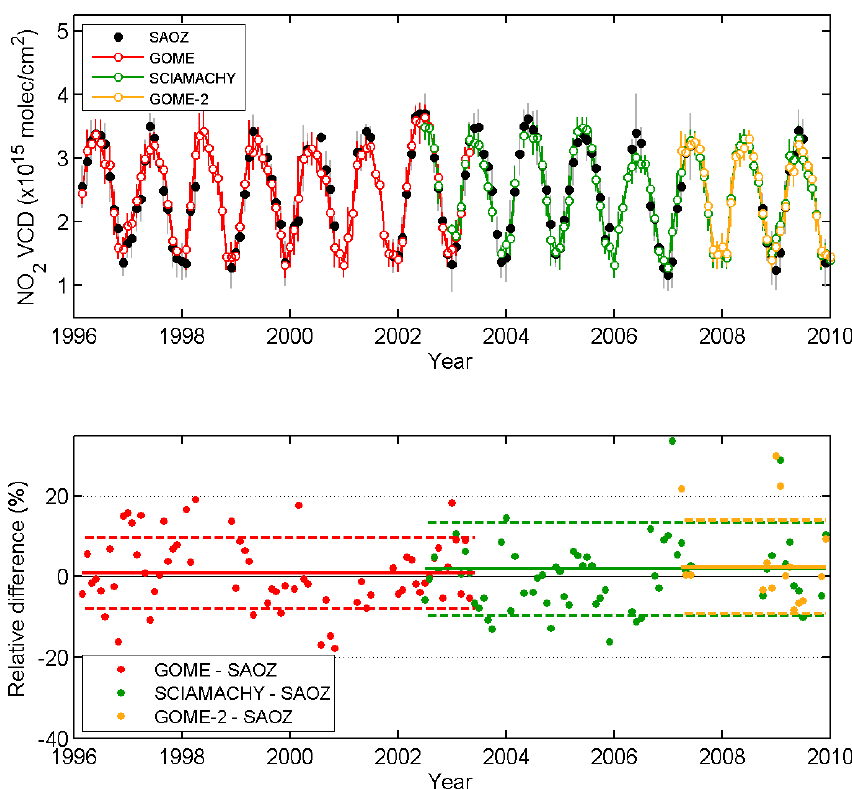
Fig. 3. Comparison between SAOZ and satellite nadir (GOME, SCIAMACHY, and GOME-2) monthly mean stratospheric NO 2 columns at Jungfraujoch (46.5 ◦ N, 8 ◦ E) for the 1996–2009 period. The error bars correspond to the 1-sigma standard deviation (natural variability). The relative differences appear on the lower plot with solid and dashed colored lines corresponding to the mean satellite – SAOZ differences and their one-sigma standard deviation, respectively, which are + 0.9 ± 8.8% (GOME), + 1.9 ± 11.5% (SCIAMACHY), and + 2.3 ± 11.6% (GOME-2).